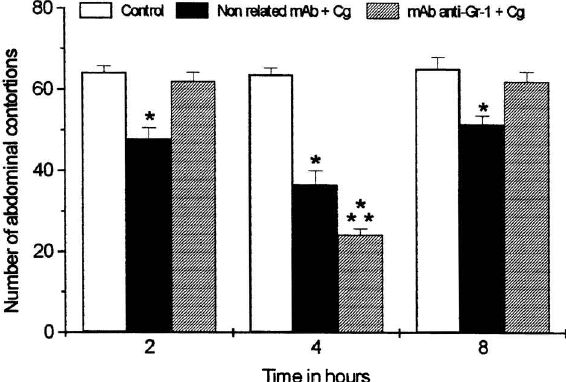
FIG. 2. Effect of carrageenan (Cg) on painful sensibility of mice evalued in the writhing test. The test was applied in different times after the i.p. injection of Cg (300 m g/0,2ml per animal). Controls were injected only with acetic acid. Values represent the mean ±S.E.M. of 8–16 animals for each group. * p < 0.05 in comparison with values obtained in control animals.